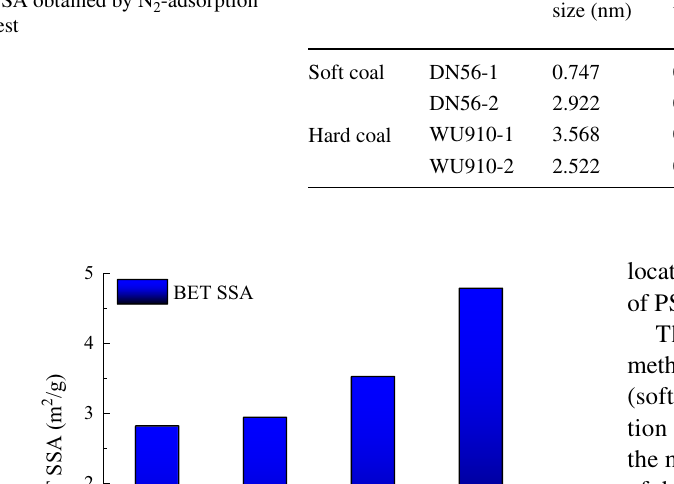
Table 2 PSDs, pore volume and SSA obtained by N 2 -adsorption test